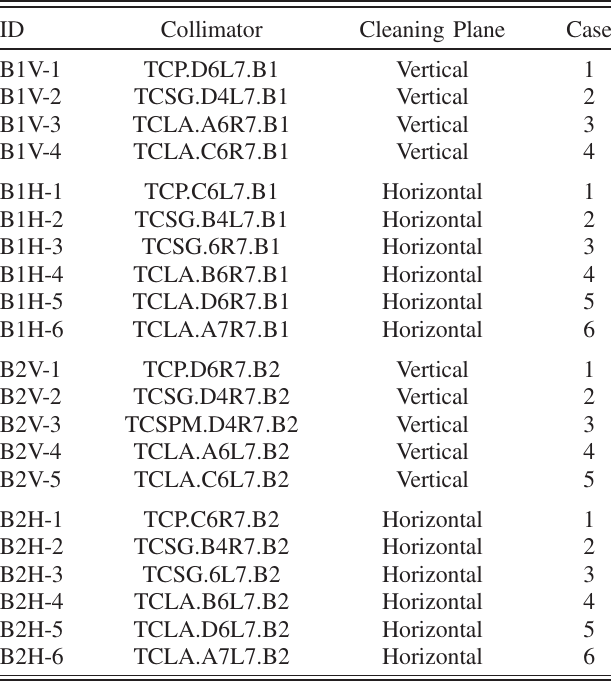
TABLE I. Individual cases of collimators that were set as the primary bottleneck and the cleaning